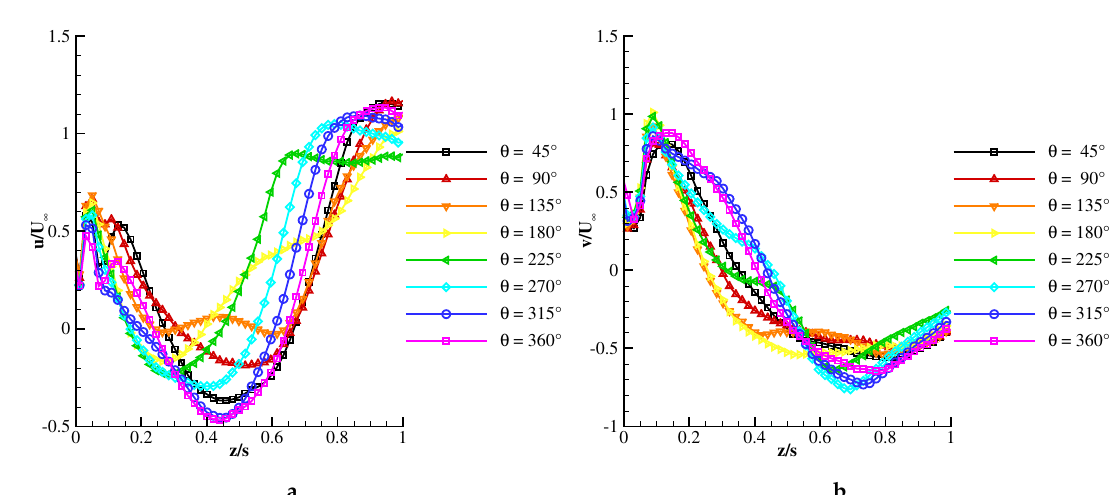
Figure 19. Phase averaged vertical velocity profiles across the forced vortex core at α = 45 ◦ , x / c r = 0.65 and y / s = 0.34. ( a ) Axial velocity; ( b ) spanwise velocity.